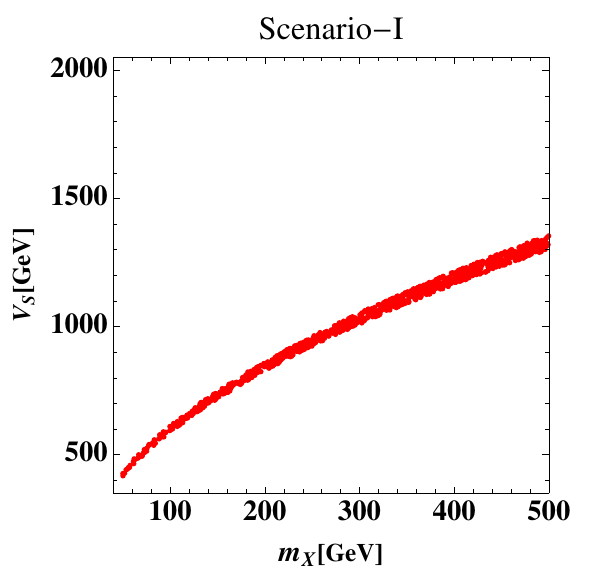
Figure 2 . Scatter plot for parameters on m X - v S plane under the DM relic abundance bound in